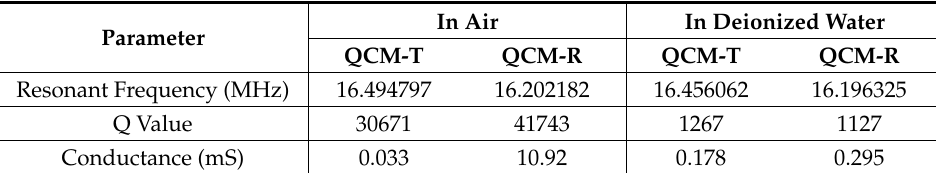
Table 1. Measured basic properties of dual channel